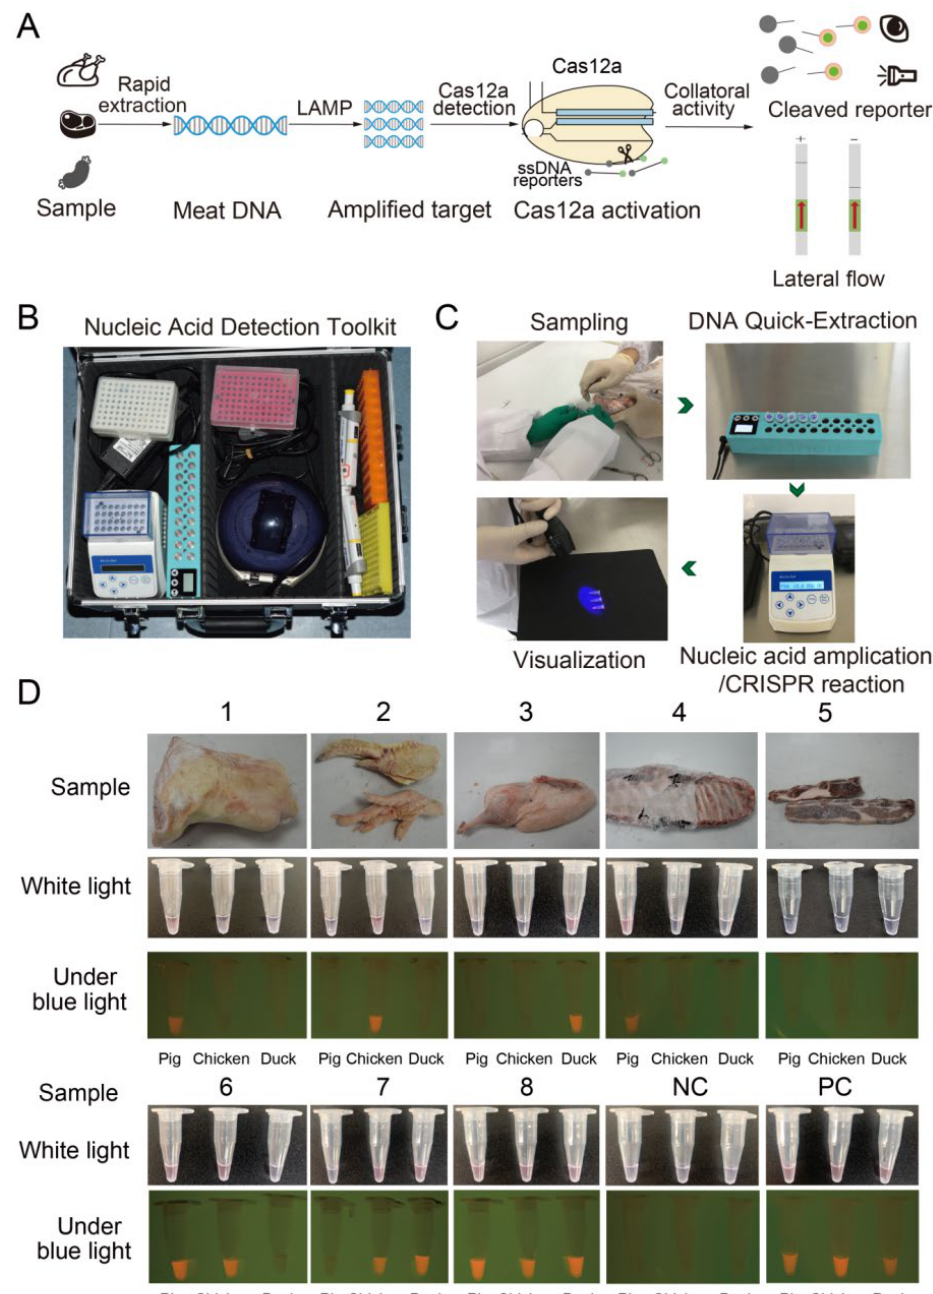
Figure 5. One-site application of the naked-eye colorimetric CRISPR/Cas12a assay for meat detection and identification. ( A ) Schematic diagram in the CRISPR/Cas12a assay for the detection of pork, chicken and duck. ( B ) Portable nucleic acid detection toolkit. ( C ) On-site nucleic acid detection steps of meat identification. ( D ) The results of meat identification in 8 samples. Samples 1–5 represent random-test meat samples, 6–8 represent mixed-meat samples. PC stands for positive control. NC stands for negative